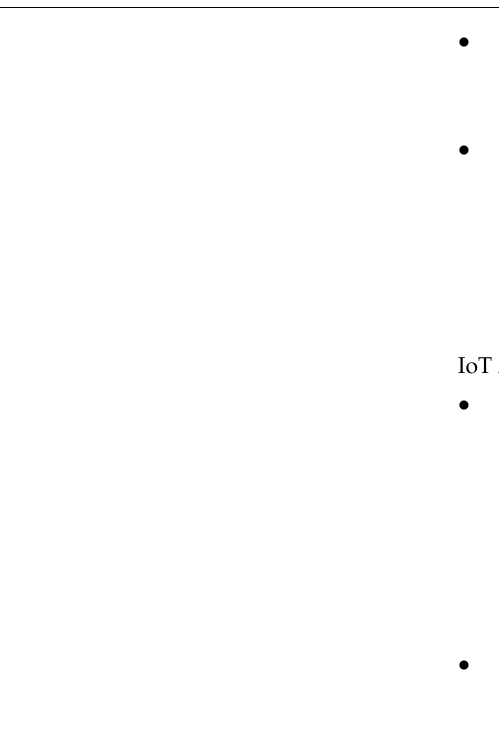
Table 5. Impact of the Sustainable Development Goals on IoT applications for improving health and the environment. SDGs Targets Goals and Application to IoT